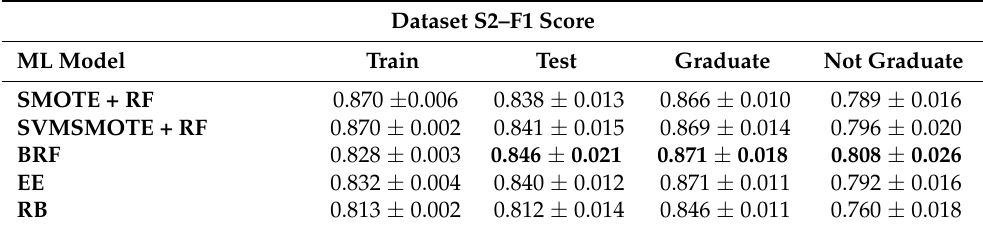
Figure 4. Confusion Matrices for the models built with dataset S2: ( a ) SMOTE + RF, ( b ) SVMSMOTE + RF, ( c ) BRF, ( d ) EE, and ( e ) RB. Table 9. F1 score evaluation (global and individual) for each learning model built with information at the end of second semester with two classes. Values represent mean and standard